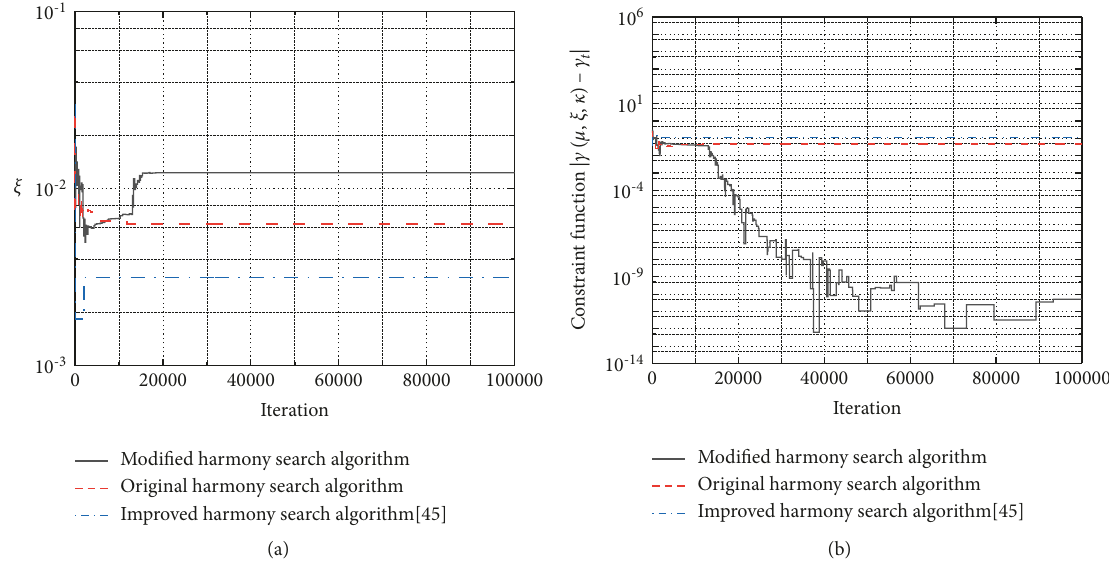
Figure 8: The variation trends of key indices during the optimization process for case 4. (a) The nominal damping ratio ξ . (b) The constraint function | c ( μ , ξ , κ ) − c t |